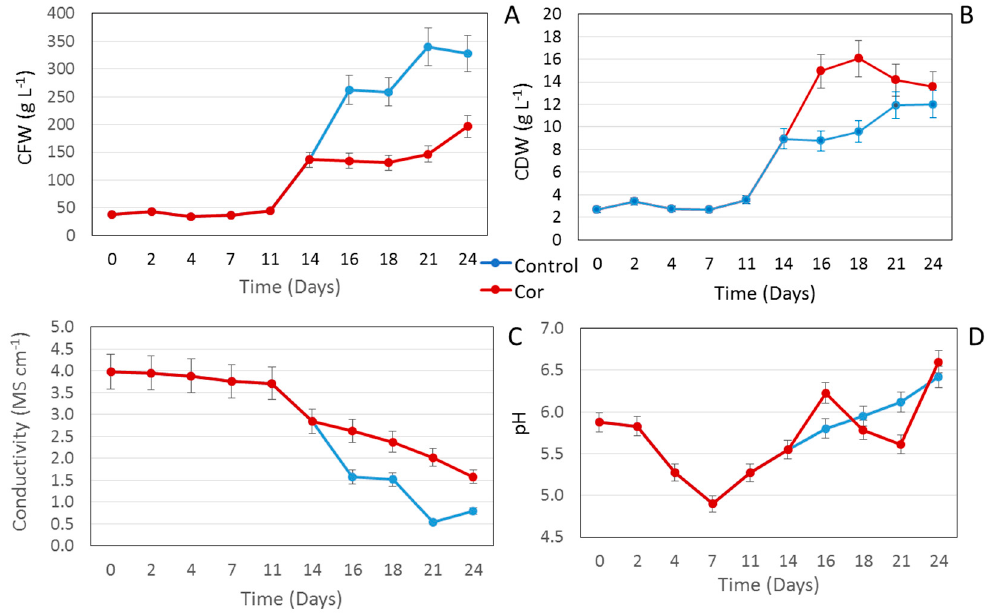
Figure 1. Time course of changes in cell fresh weight (CFW) ( A ), cell dry weight (CDW) ( B ) expressed as g · L − 1 , conductivity ( C ) and pH ( D ), over a growth period of 24 days. Each result is the average of 3 replicates ± SD.